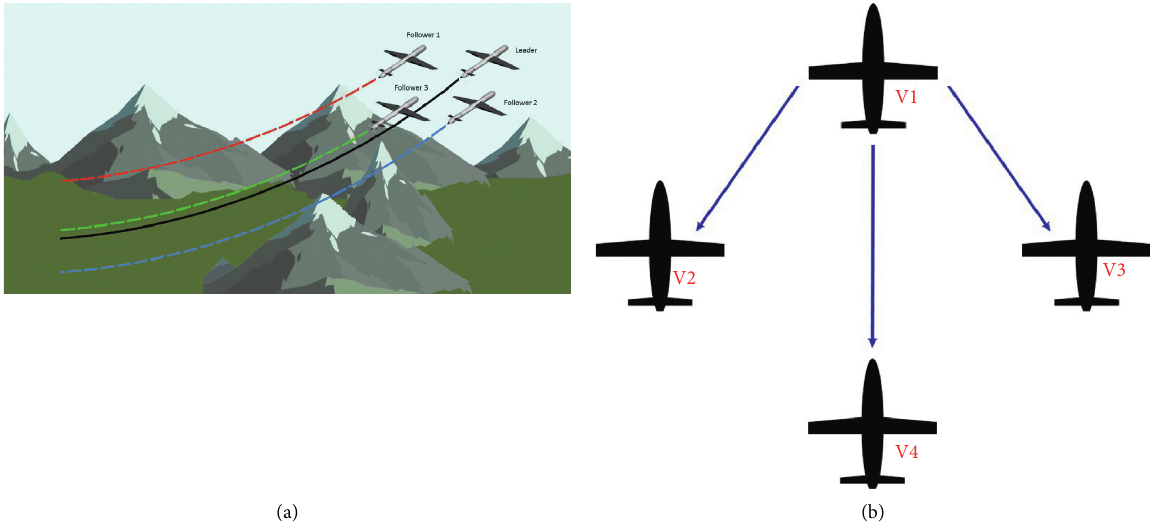
Figure 4: (a, b) A communication topology of UAV